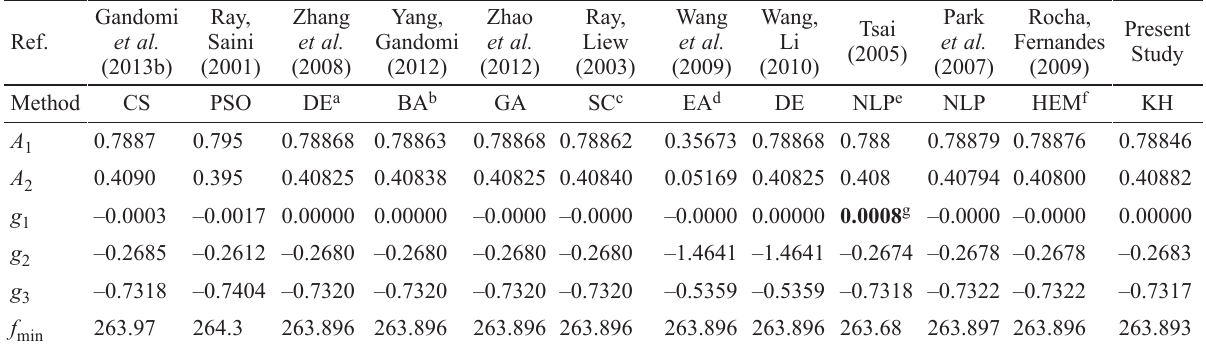
Table 4. Best solutions for the three bar truss example Ref.